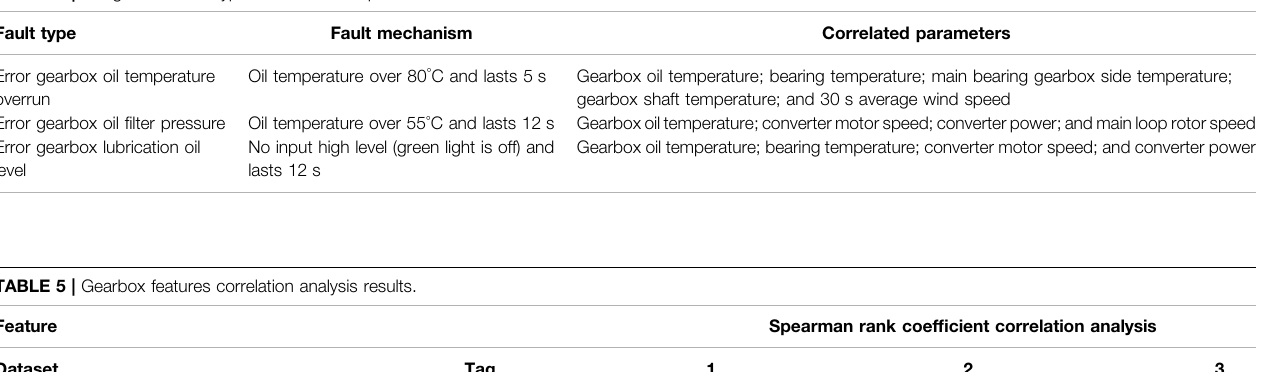
TABLE 4 | WT gearbox fault type and correlated parameters.